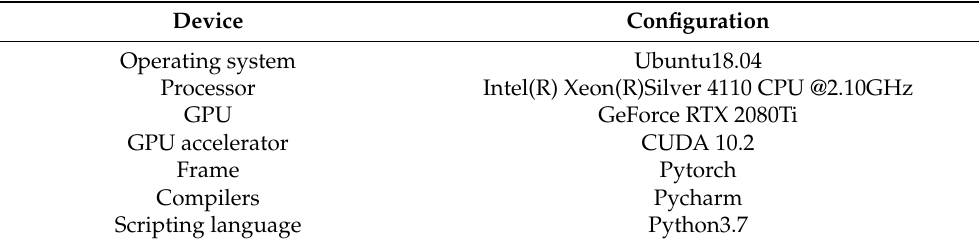
Table 1. Configuration parameters.